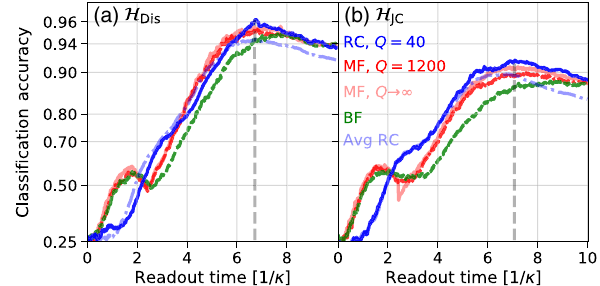
FIG. 3. A demonstration of the RC classification process. Panel (a) depicts a sample quantum signal u ð t Þ ¼ J ð q Þ ð t Þ generated by ˆ H the joint dispersive readout under of the initial state FIG. 4. Classification accuracy versus readout time on a 1200 D j ψ ð 0 Þi ¼ j 11 i . This drives a K ¼ 5 node RC, producing the signal test set for the dispersive system in (a) and the JC system in (b). In both cases, the RC of Fig. 3 (solid blue line) is trained with node state dynamics x ϕ k ð t Þ shown in (b). The classification result k Q ¼ 40 measurements and the optimal readout time is indicated. is in (c): the RC, previously trained with Q ¼ 40 readout signals, The average classification fidelity of 10 different random RCs continuously updates the probability that the initial state was a sharing the same hyperparameters is also shown in light dash- specific state in the measurement basis. These probabilities are dotted blue line. For comparison purposes we also show the shown in solid lines in the color-scheme of Fig. 1. The classification accuracy of a BF (dashed green line), analytic MF decomposition of the true quantum state conditional on the (light red line), and Q ¼ 1200 MF (dash-dotted red measurement record up to time t is depicted in lighter dashed lines; for this sample the RC output is correct after ∼ 3 = κ . Note 2 ð t Þ (and associated P ) are vanishingly small. that j c 01 = 00 j